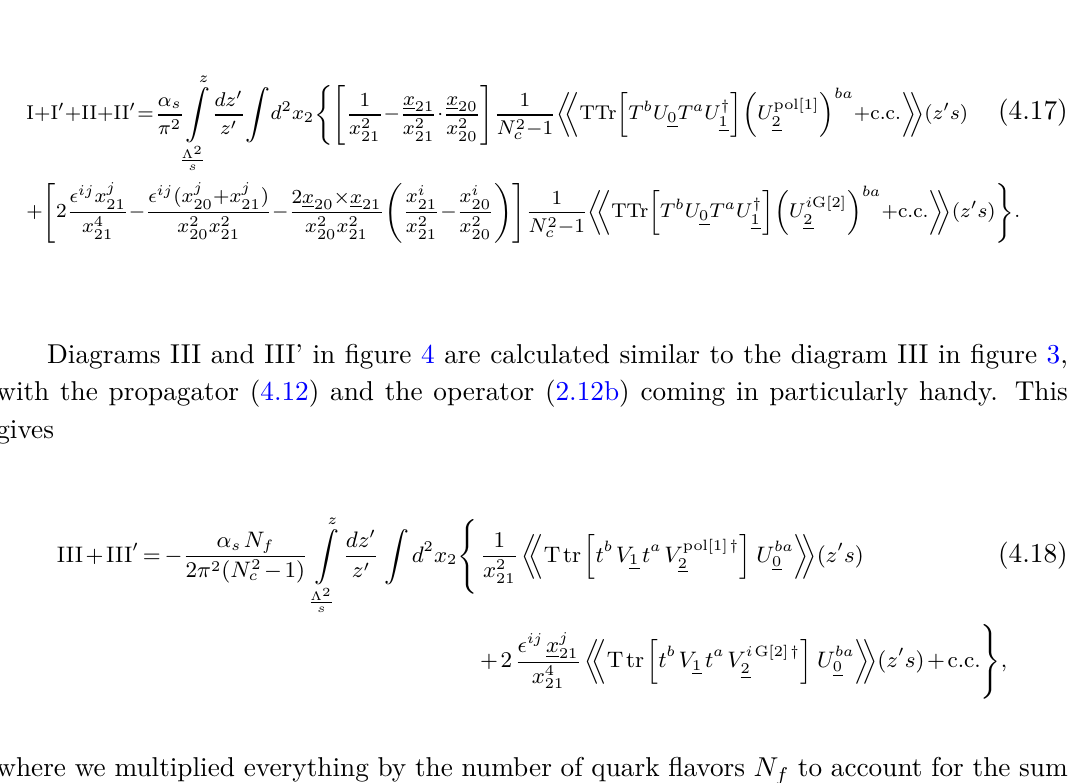
Figure 4. Diagrams representing the evolution of the adjoint polarized dipole amplitude G adj Again, the square box on the gluon and quark lines represents the sub-eikonal interaction with the target given by eq. (2.10) for gluons and eq. (2.5) for quarks. The same square box, but with number 1 in it, on the gluon line denotes the interaction described by U pol[1] denotes the sub-eikonal triple-gluon vertex generated by the F 12 operator in eq. (2.12a), that is, by the F 12 part of U pol[1]